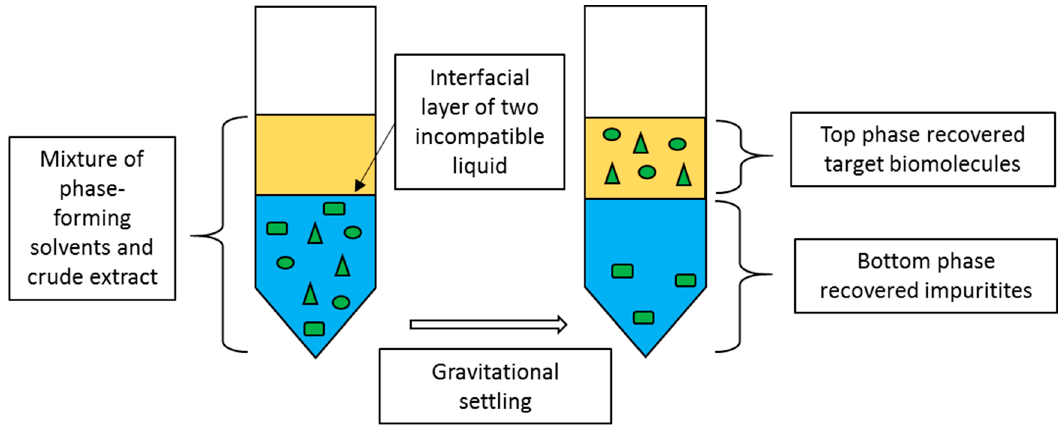
Figure 1. Schematic diagram of the principle in the liquid biphasic system (LBS).